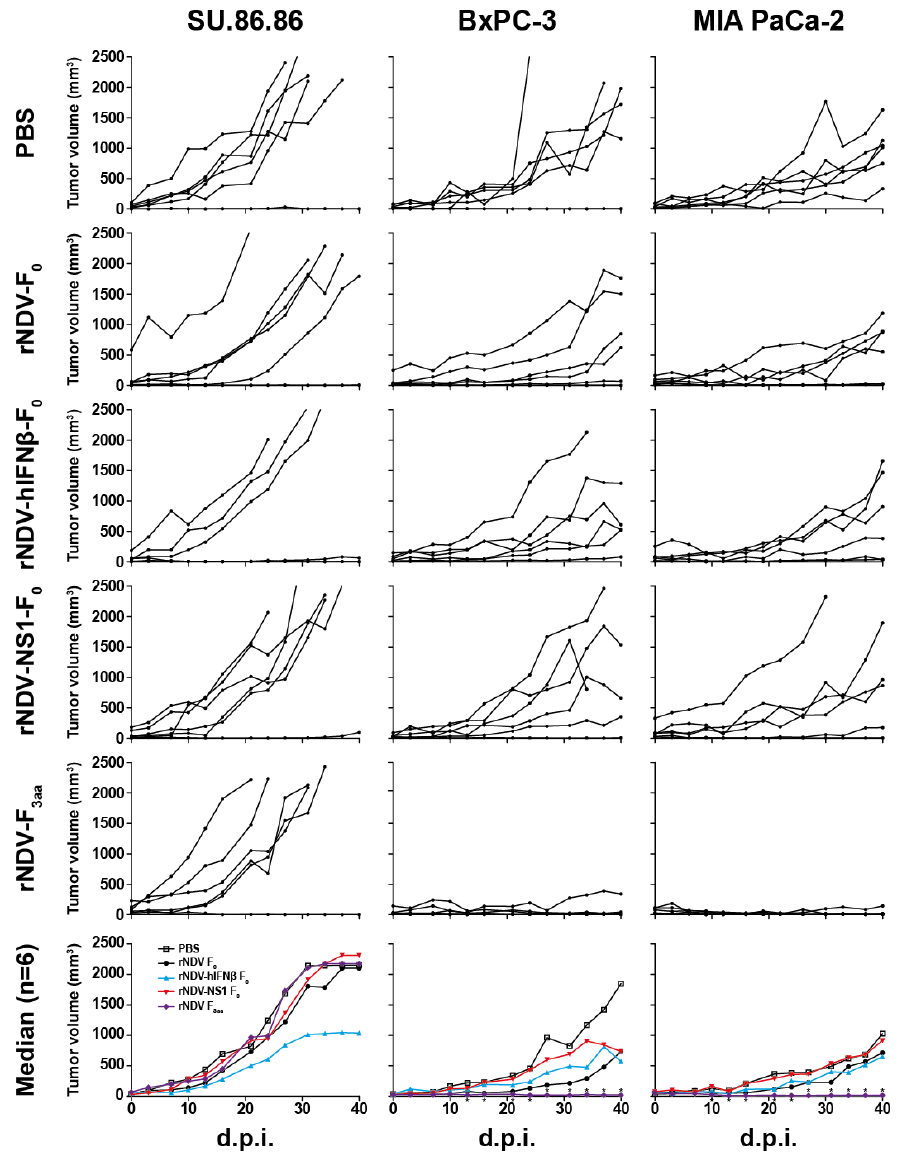
Figure 5. Efficacy of rNDV treatment in a mouse model using SU.86.86, BxPC-3 or MIA PaCa-2 subcutaneous tumor xenografts. Animals were treated and evaluated as described in the material and methods section. Graphs with specific xenograft-treatment combinations depict individual mouse tumor volumes with black lines and dots. Last observed tumor volumes were carried forward to calculate median volumes per group in the lowest plots.